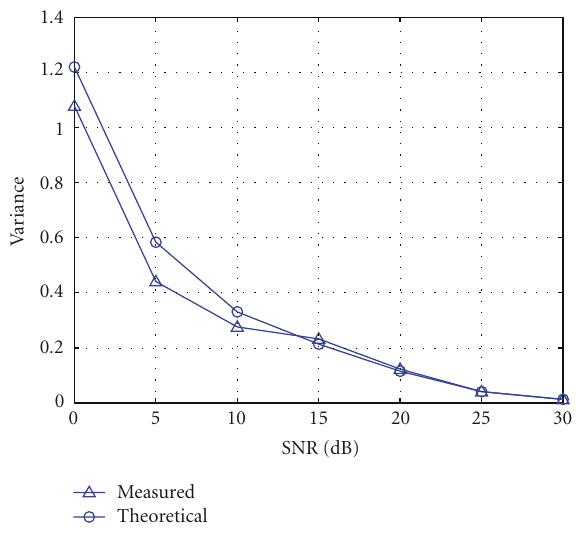
Figure 10: BER versus SNR for LDPC (3312, 1397) coded system and ROBO mode over an AWCN ( A = 0 . 1, GIR = 0 . 1) channel and a multipath channel.